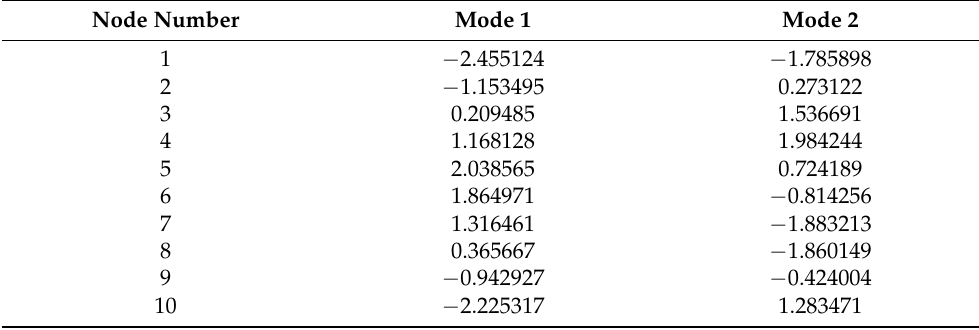
Table 7. Experimental normalized mode shapes obtained from the modal test of the damaged steel beam.